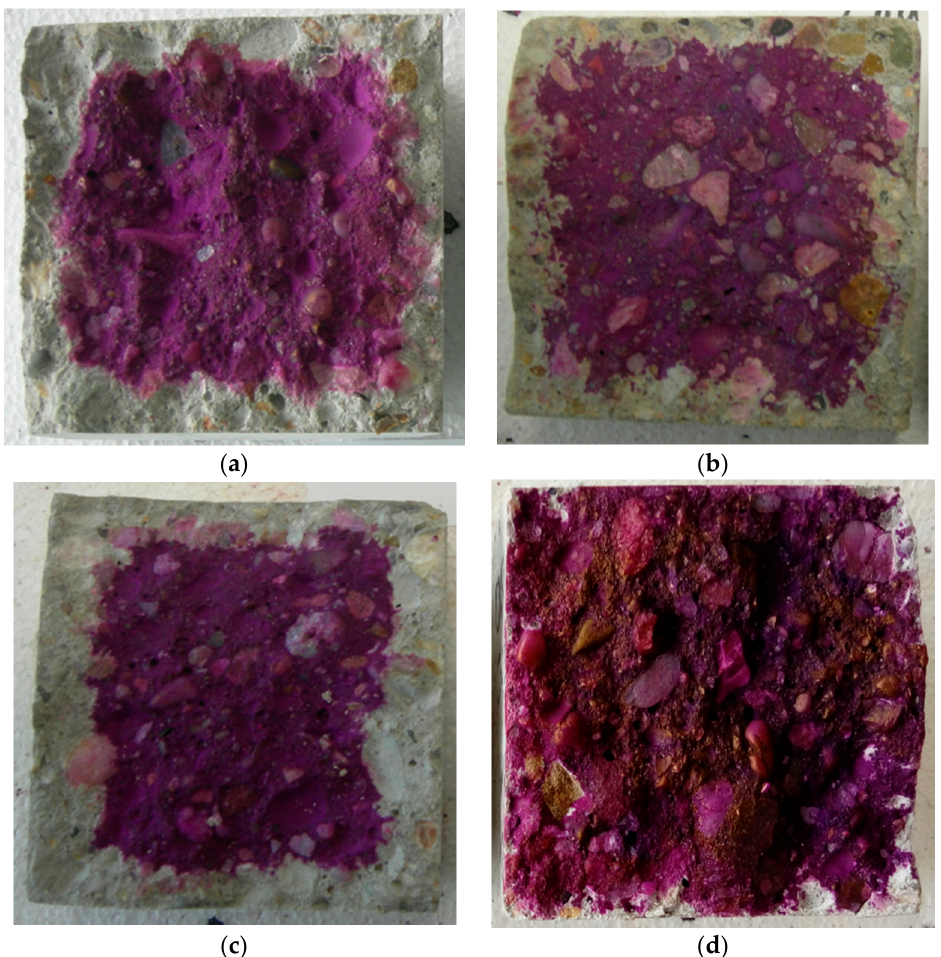
Figure 6. Carbonation depth—concretes XC4.